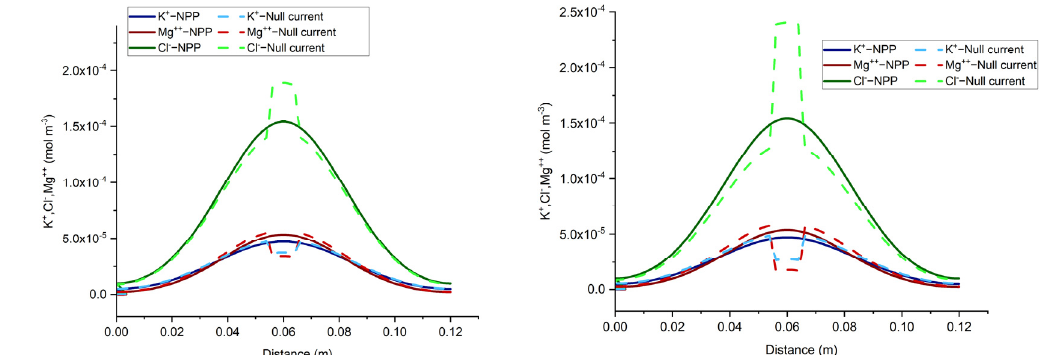
Figure 3. Comparison of total concentration results of the NPP and NC-models for 1D simulations of the three benchmarks in the case of adsorption reactions. Test case 1 deals with low sorptivity while test case 2 deals with high sorptivity. ‘Test case 1 ′